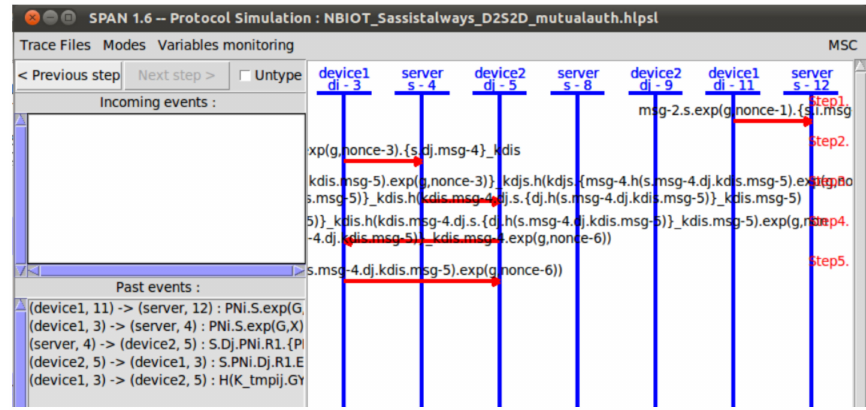
Figure 11. The message exchange of the S-assist-always D2S2D authentication.